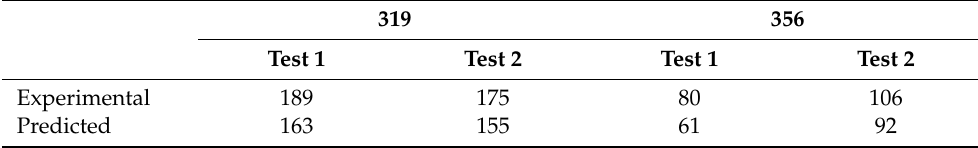
Table 8. Experimental and predicted TMF lifetimes under 0.4% strain amplitude for the two